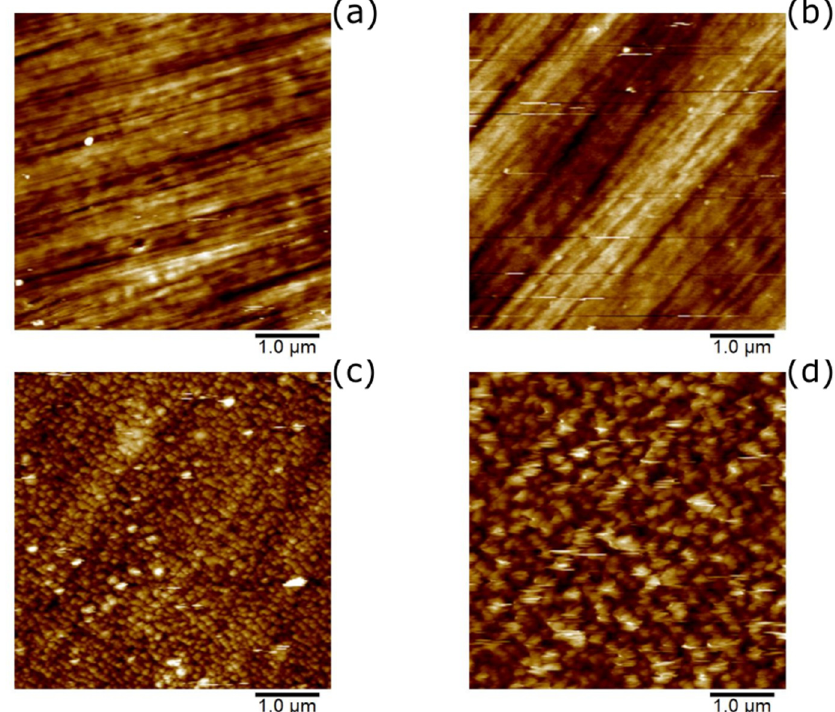
Figure 8. AFM images ( a ) before plasma treatment, ( b ) after the 1-min treatment, ( c ) after the 5-min treatment, and ( d ) after the 20-min treatment at the base plume position with a 2.5 L/min flow rate taken with NanoScope Analysis ( NanoScope Analysis (32 bit) , version 1.50 (Build B72.115792); Bruker Corporation: 2015.).